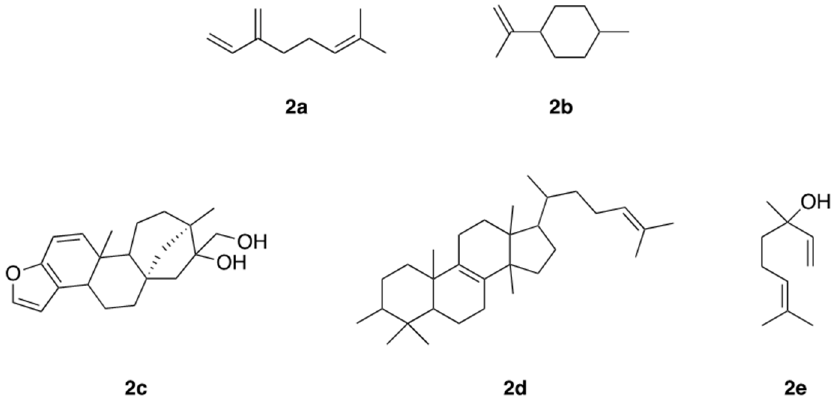
Figure 2. Structures of terpenes and terpenoids: acyclic monoterpenes ( 2a ), cyclic monoterpenes ( 2b ), diterpenes ( 2c ), triterpenes ( 2d ), and terpenoids ( 2e ).